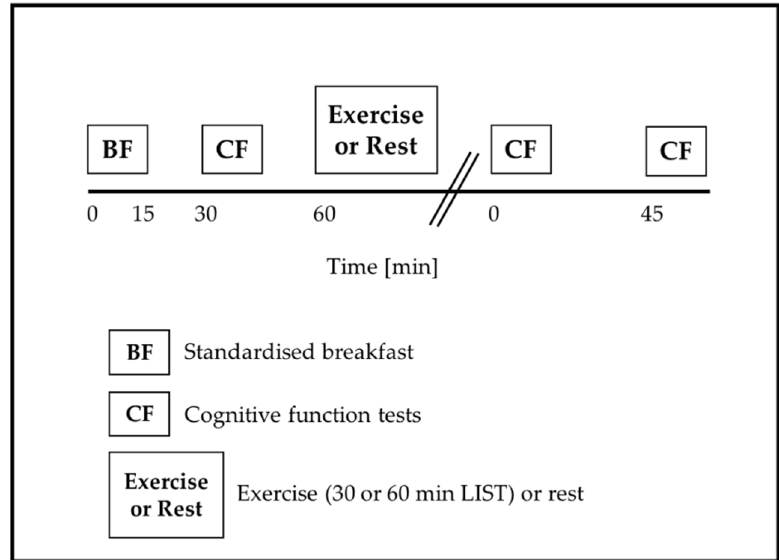
Figure 1. Experimental trial protocol.